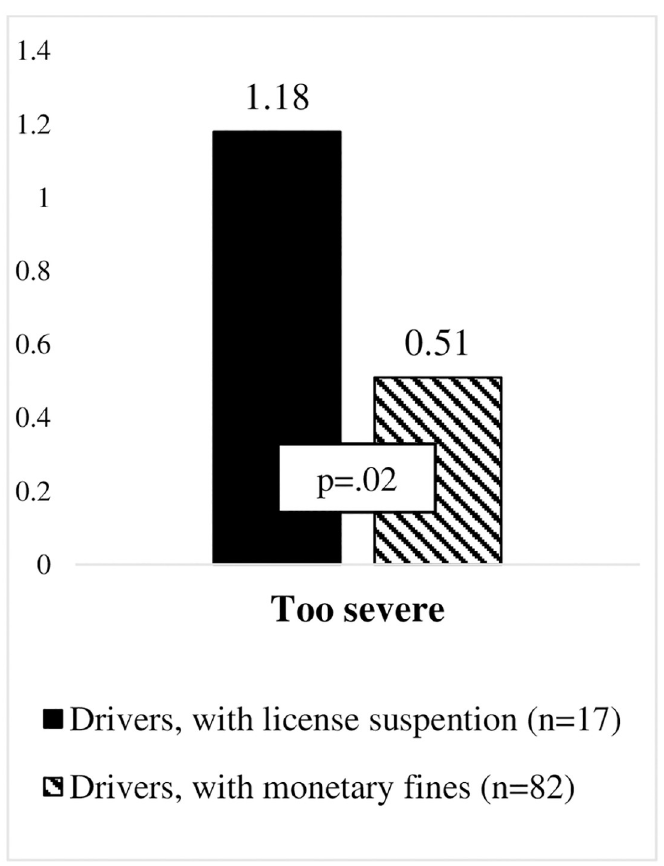
Fig 5. Illustration of differences in evaluation of penalties for abberant driving among drivers with license suspension and monetary fines.